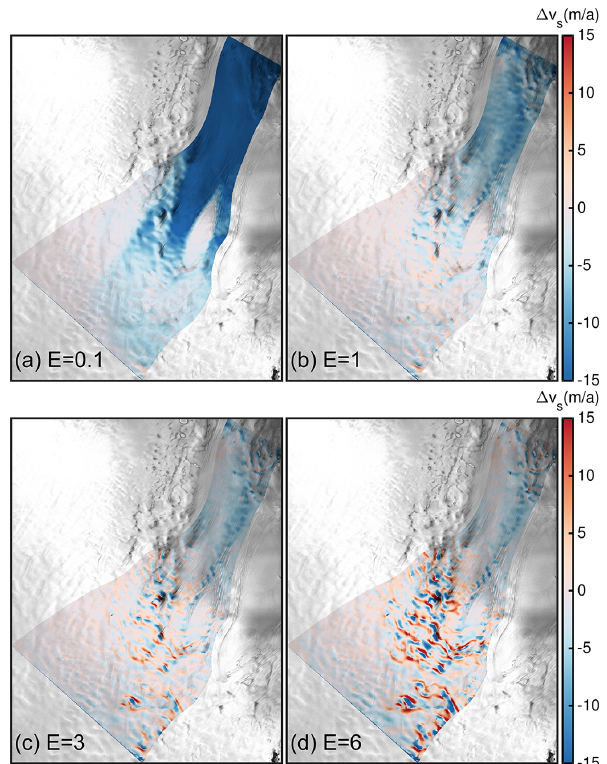
Figure 4. Difference of surface velocity (cid:49)v FS − BP-like s = v FS s − v BP-like s for a resolution of 100m. (a–d) Differences for E = 0 . 1, 1, 3 and 6, respectively. Background image is a RADARSAT Mo- saic (Joughin, 2015; Joughin et al., 2016).